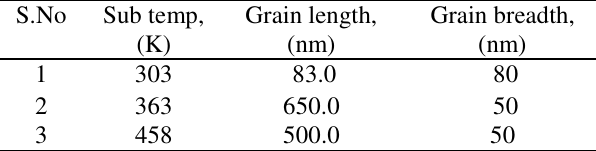
Table 3 Variation of grain size with substrate temperatures for the NiPc thin films